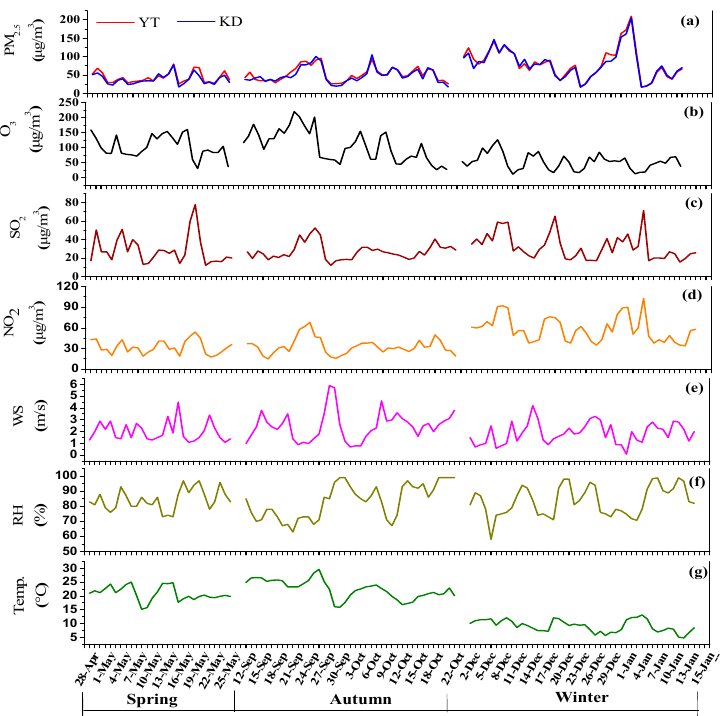
Figure 2. Concentrations of PM 2.5 , O 3 , SO 2 , and NO 2 , and meteorological data during the sampling periods: ( a ) PM 2.5 ; ( b ) O 3 ; ( c ) SO 2 ; ( d ) NO 2 ; ( e ) wind speed; ( f ) relative humidity; and ( g ) ambient